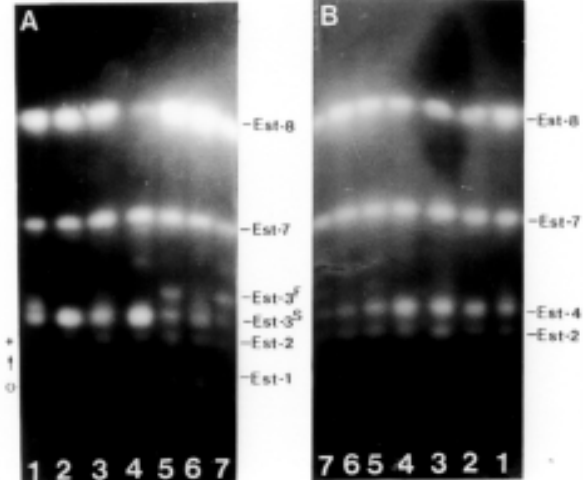
Figure 1 - Isoesterases of Diatraea saccharalis pupae on starch gel and Tris/citratebuffer,pH7.0showingallelicvariationforthe Est-3 locusinA (4-methylumbelliferyl acetate) and the preference of the Est-2 and Est-8 isozymes for 4-methylumbelliferyl acetate and butyrate (A, B), and Est-4 isozymefor4-methylumbelliferylbutyrate(B).Samples1,3,5,6,7corre- spond to the Est-3 F/S isozyme phenotype; samples 2 and 4 correspond to the Est-3 S/S isozyme phenotype.